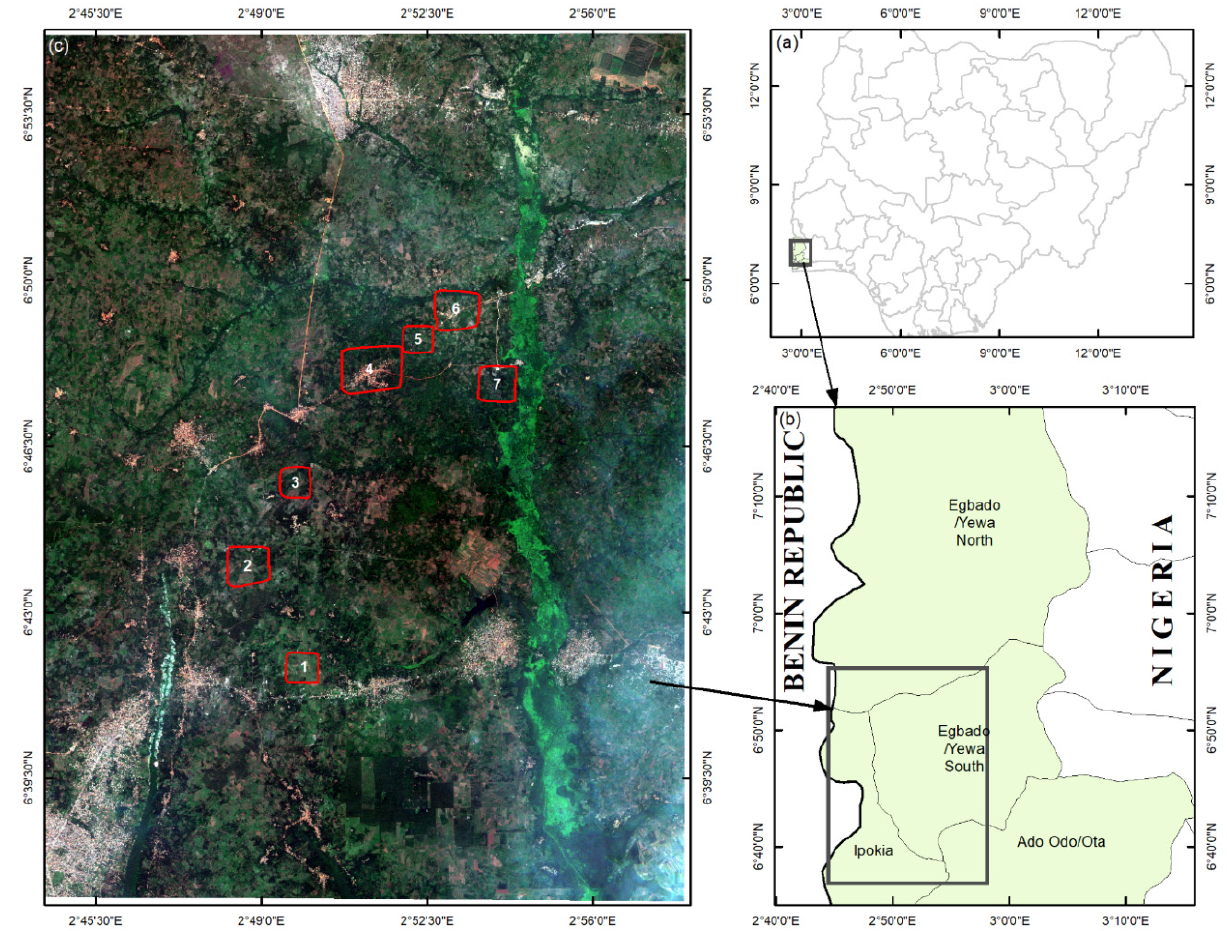
Figure 1. ( a ) Geographic location of the study area in Nigeria. ( b ) Map of four local government areas (LGAs) affected by the banana bunchy top virus (BBTV) in the Ogun state, Nigeria, where the area used for banana and BBTV assessment is indicated by a black rectangle. ( c ) Natural color composite of the Sentinel 2A map of the study area with markings of the seven UAV flight sites (red outlines). (1) Okoeye, (2), Olujere, (3) Erimi, (4) Olokuta, (5) Ipaja Road, (6) Ipaja Town, and (7) Igbeji.